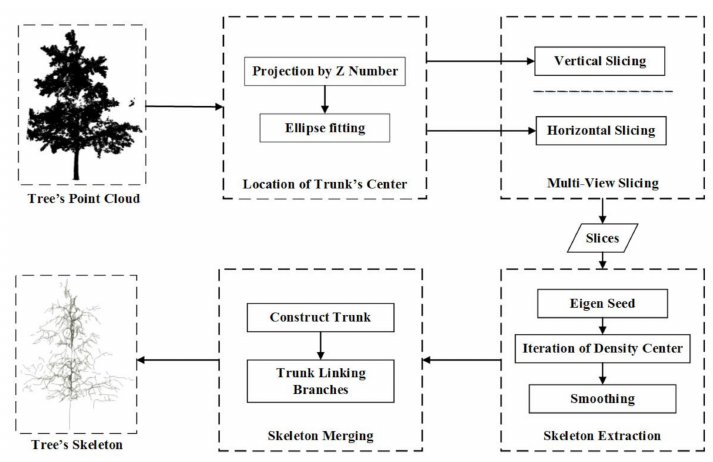
Figure 2. The overview of the proposed framework.